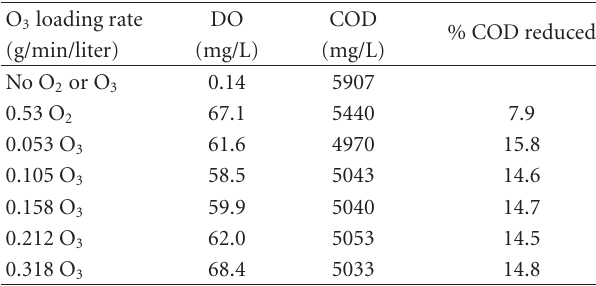
Figure 2: Close-up of aerosol bubble mass transfer. Table 3: DO and COD as a function of Ozone/Oxygen injection